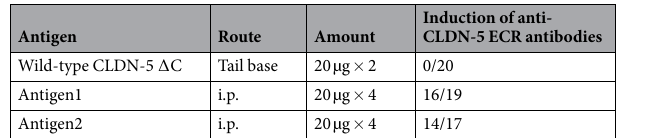
Table 1. Result of immunization